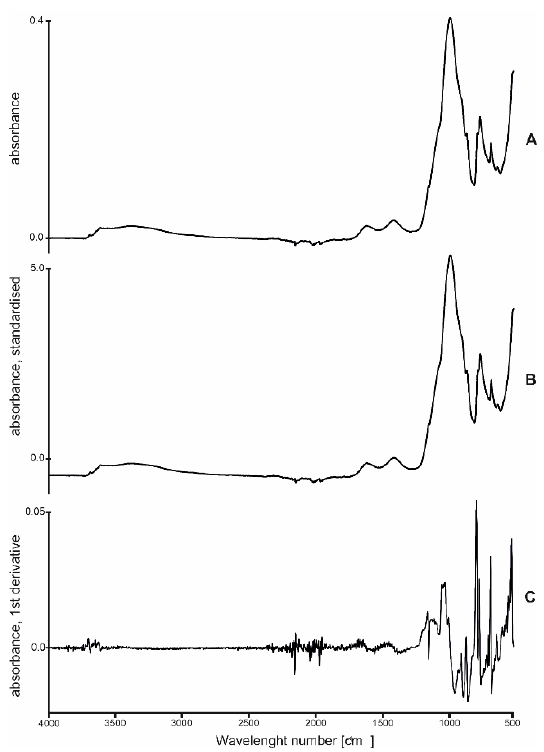
Figure 2. Mid-infrared absorbance spectra: A —without processing, B —after standardization, C —after standardization and 1st derivative.